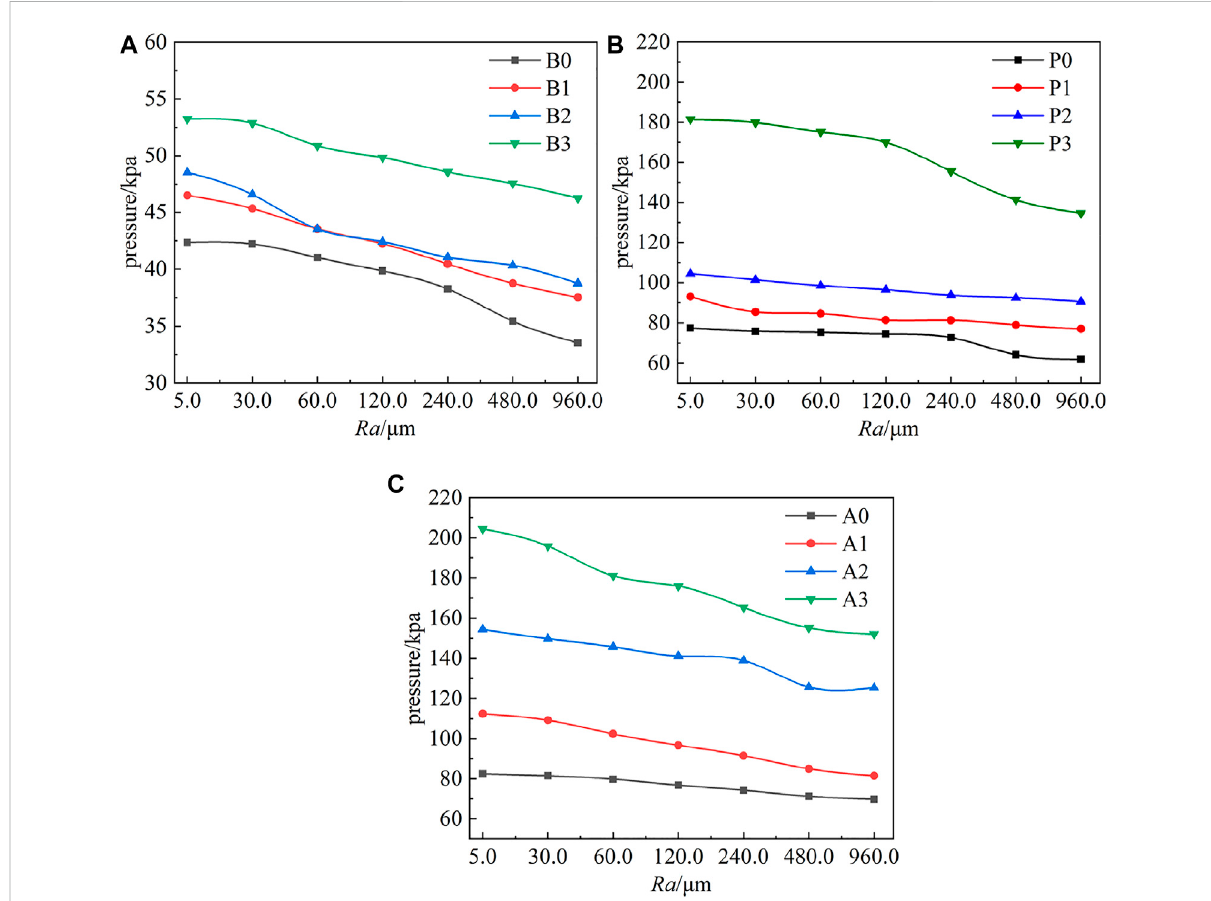
FIGURE 15 Static pressure variations with roughness at different monitoring point: (A) span 0.1, (B) span 0.5, and (C) span